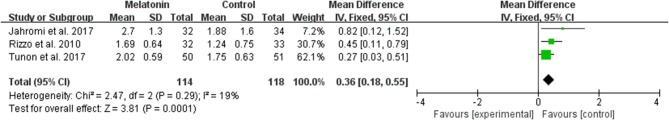
Meta-analysis of studies reporting the number of top quality embryo. Meta-analysis of the data from 3 of the included studies that reported the number of top quality embryo showed that women treated with melatonin had a significantly increased number of the top quality embryo from ART.